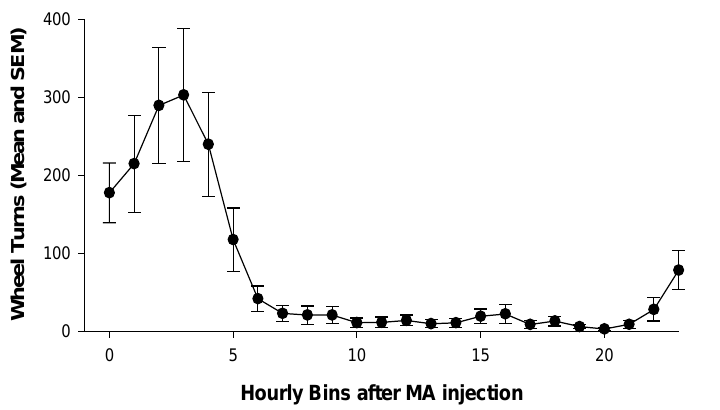
FIGURE 1 . Wheel running (Mean ± SEM) in eight rats given MA (2 mg/kg) injections at 24-h intervals. Four of the rats were given ten injections at time 1200; the other four rats were given 17 injections at time 1900. In the figure, the injection time is normalized to time 0. MA had a direct stimulant effect that lasted about 5 h. Circadian anticipatory wheel running can be seen beginning at about hour 22, 2 h before the next injection. These rats were housed without time-of-day cues, under constant dim light, and rate-limited feeding. (Modified from Kosobud et al.[32]; used with